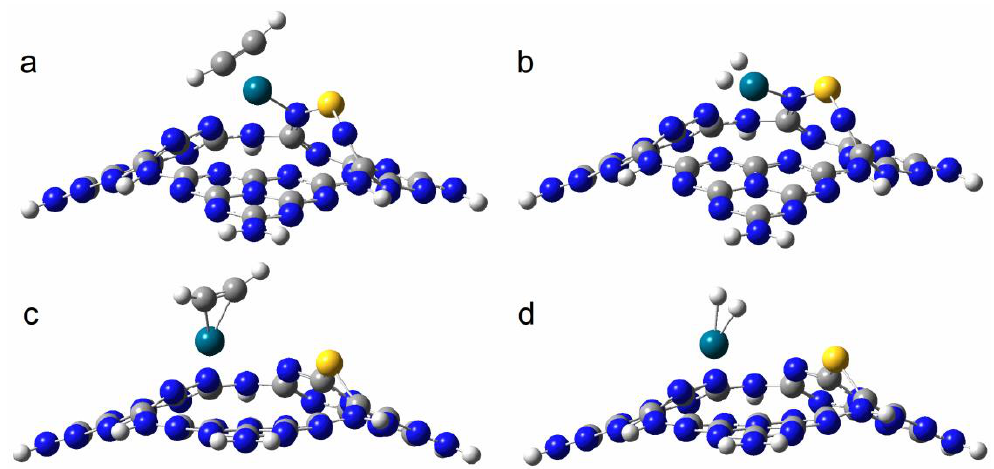
Figure 3. ( a , b ) and ( c , d ) represent the optimum adsorption configurations of acetylene and hydrogen on S doped Pd 1 /C 3 N 4 at C and N sites respectively.